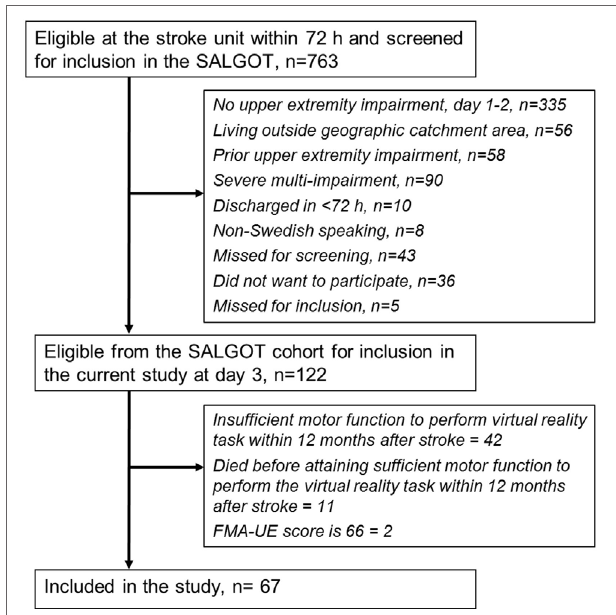
FigUre 1 | Flowchart of the inclusion process. Abbreviations: SALGOT, Stroke Arm Longitudinal Study at Gothenburg University; FMA-UE, Fugl-Meyer Assessment for upper